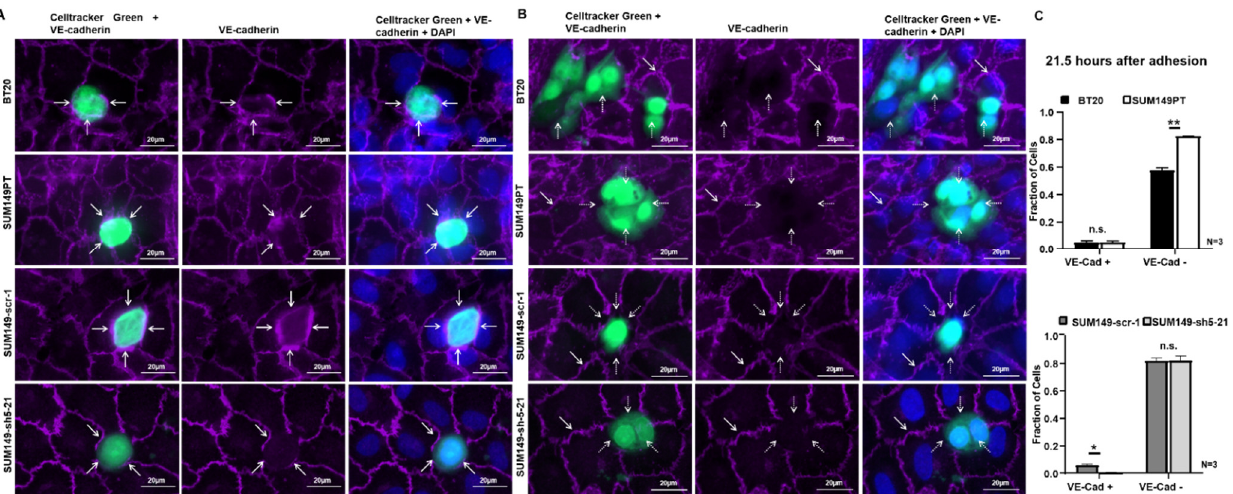
Figure 4. BT20, SUM149PT, SUM149-scr-1 and SUM149-sh5-21 cells destroy the VE-cadherin-mediated endothelial cell-cell contacts at a late stage of incorporation. The incorporation experiments were stained by immunofluorescence for VE-cadherin (purple) 21.5 h after the start of the experiment. Tumor cells green, 40x magnification and additional + 48% digital zoom. ( A ) VE-cadherin was present at the contacts between HUVEC and BT20, SUM149PT or SUM149-scr-1 cells, potentially reflecting homophilic interaction between tumor and endothelial cells (white arrows). At the contacts between HUVEC and SUM149-sh5-21 knockdown cells, only endothelial VE-cadherin was visible. Endothelial VE-cadherin between the HUVECs was also present in all images. We interpreted this as an early stage of incorporation; ( B ) BT20, SUM149PT, SUM149-scr-1 and SUM149-sh5-21 cells disrupted the VE-cadherin mediated HUVEC cell-cell contacts at the site of tumor cell incorporation. BT20, SUM149PT and SUM149-scr-1 cells did not express VE-cadherin on the surface (white dotted arrows); the VE-cadherin staining between adjacent HUVECs was however preserved (white arrows). This might be interpreted as the late stage of the incorporation process; ( C ) Quantification of incorporation by VE-cadherin immunofluorescence analysis 21.5 h after the start of the experiment. Fraction of tumor cells with endothelial VE-cadherin at junctions to HUVEC (VE-Cad +) and tumor cells that disrupted endothelial VE-cadherin (VE-Cad −). Bars represent standard deviation; n.s. not significant, * p ≤ 0.05; ** p ≤ 0.01; statistical analysis was conducted using two-way ANOVA.